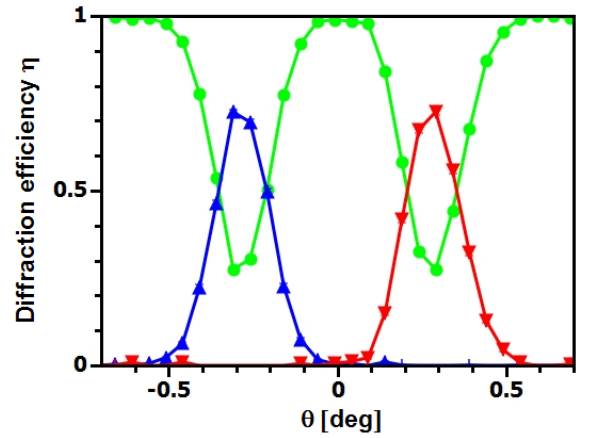
Figure 11. Rocking curves of a d-PMMA grating ( Λ = 381 nm) measured at λ ≈ 3 . 8 nm and different tilt angles ζ